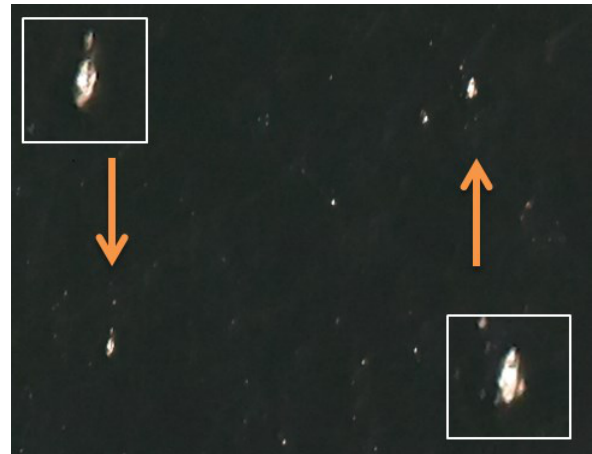
Figure 3. Bird or phenomenon? Wave crests and sun glitter often are indistinguishable from real birds. Starting from a MSER mask, we calculate its center of gravity and use the center point to extract a sub-image of 64 x 64